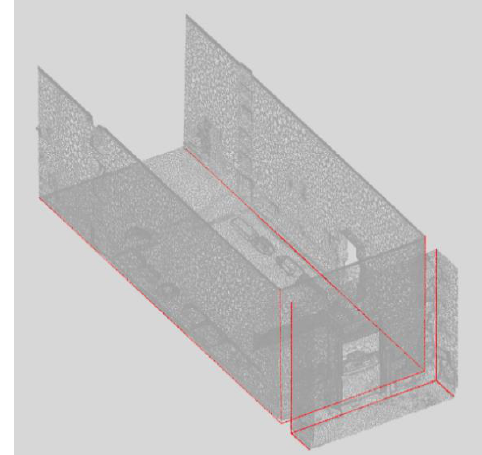
Figure18: Depiction of the initial point cloud with all edges